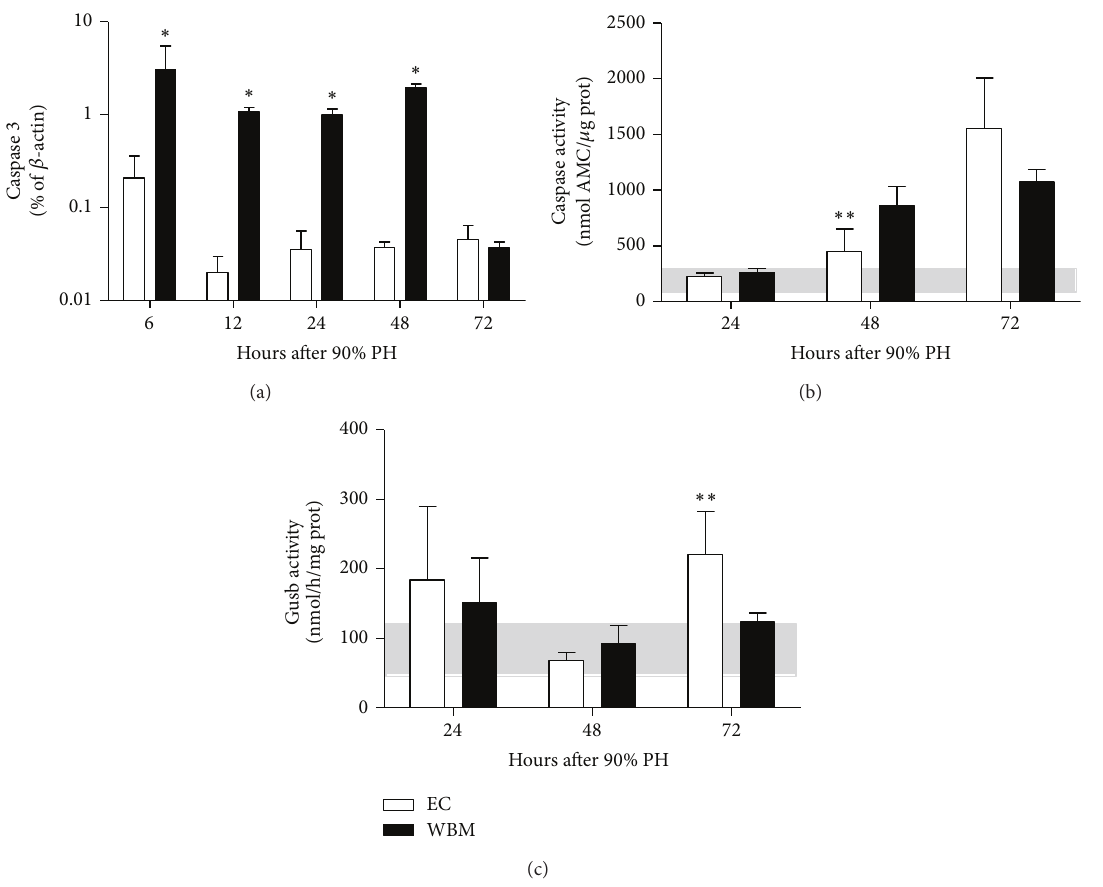
Figure 4: Mechanisms of cell death after 90% partial hepatectomy (PH). (a) Liver gene expression of Caspase 3 at 6, 12, 24, 48, and 72 hours after 90% PH. (b) Caspase 3 activity and (c) lysosomal- 𝛽 -glucuronidase (Gusb) activity at 24, 48, and 72 hours after 90% PH. Gray bar indicates normal values. WBM: whole bone marrow; EC: empty capsules. Values are expressed as means ± SD. Student’s 𝑡 -test, ∗ 𝑃 < .05 ; ∗∗ 𝑃 < .01